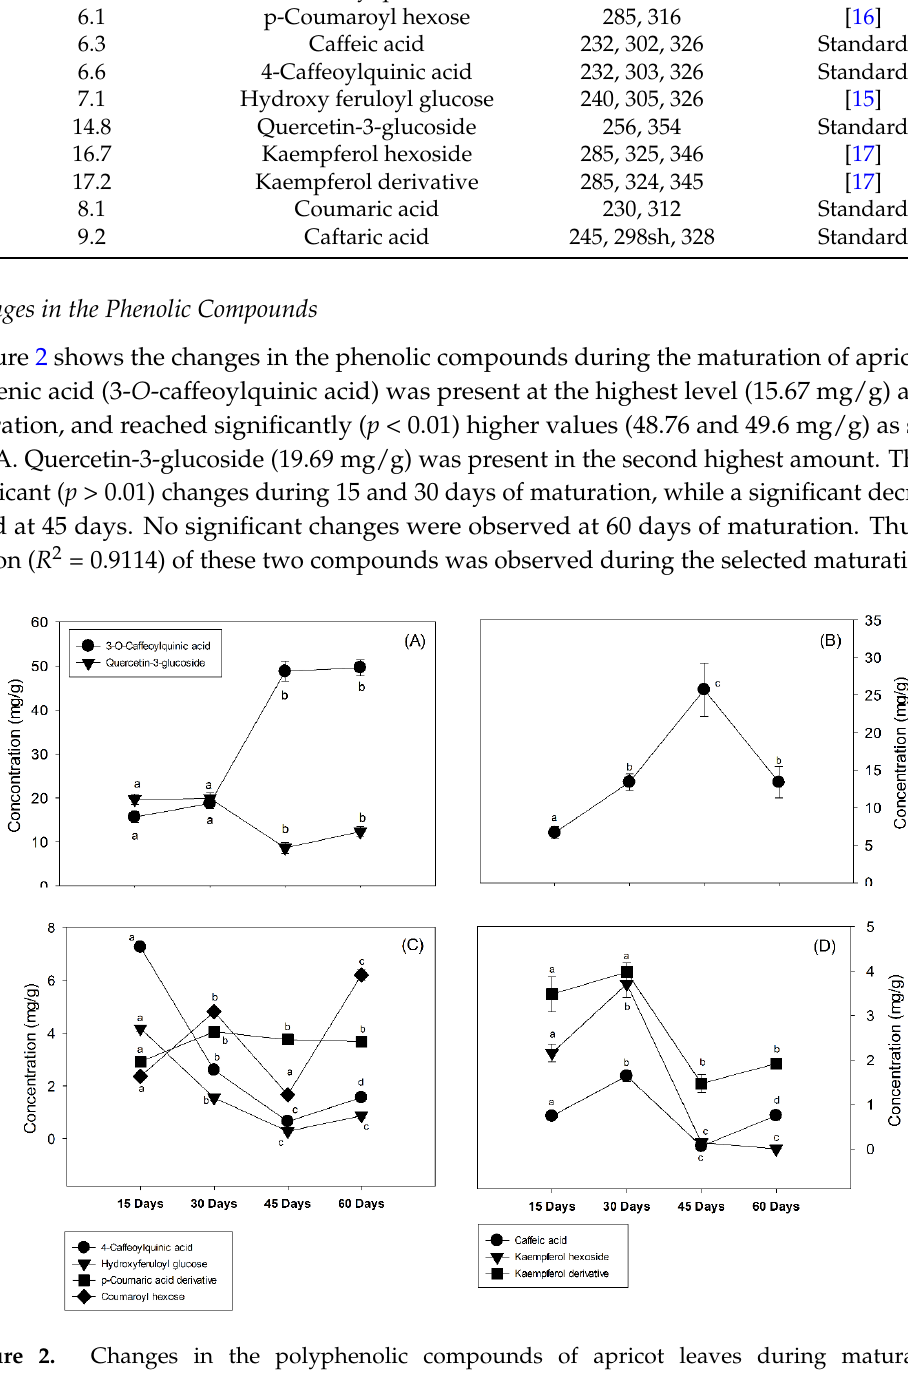
Table 1. Identification of polyphenolic compounds in apricot leaf samples.